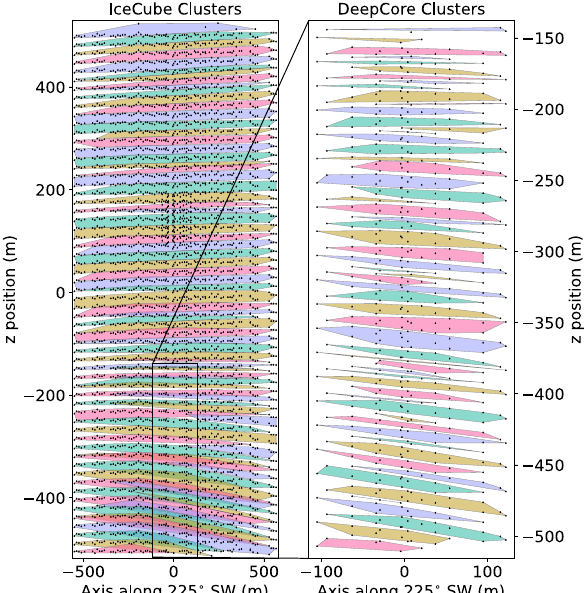
Fig. 10 The grouping of DOMs into 140 separate ice property clusters via k-means, 80 for the larger IceCube volume (left), and 60 for the DeepCore volume (right). The plot shows the convex hull from DOM positions (black dots) in common clusters, and the varying colors are visually separating the clusters. At first order grouping happens in z - layers, while tilt behavior can be also be seen along the direction of the